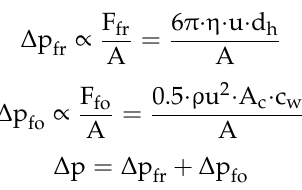
Figure 11. Schematic drawing of the test section with the flow in the hot and cold flat tubes marked in red and blue, the symmetry plane T plane between the flat tubes marked in green, and the system boundary for deriving Equation (1). Reproduced with permission from [16], published by Elsevier